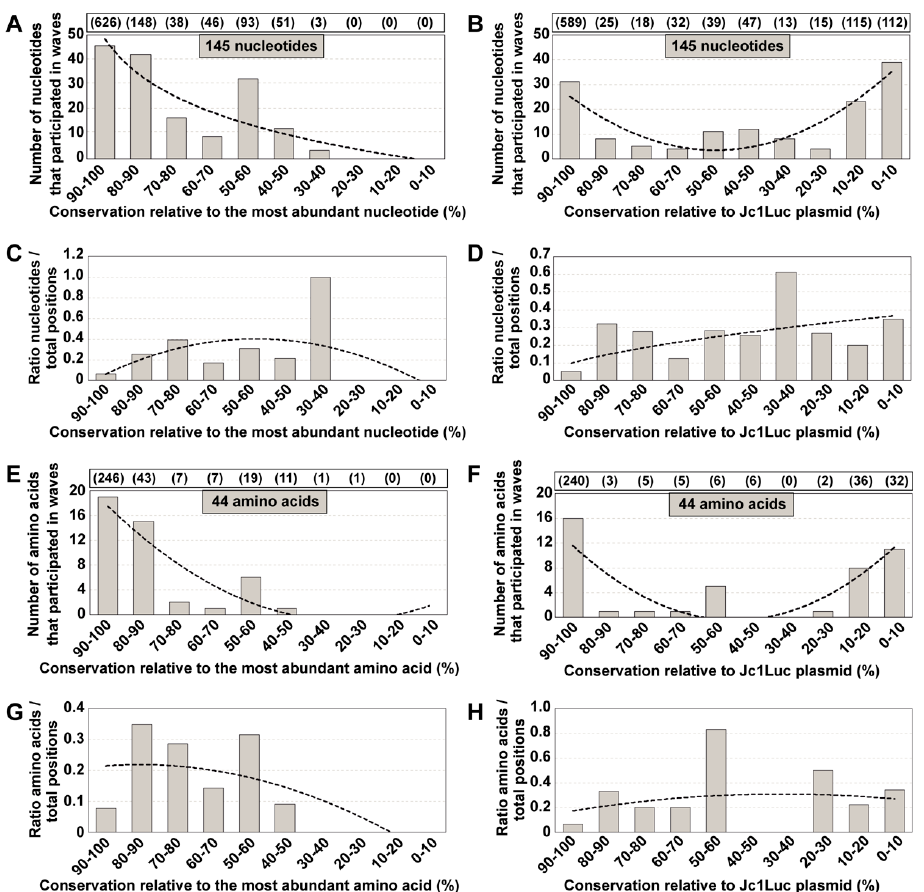
Figure 4. Degree of conservation of nucleotides and amino acids that participated in mutational waves, according to the Los Alamos National Laboratory (LANL) alignment. ( A ) Number of nucleotides involved in mutational waves distributed among conservation groups, calculated relative to the most abundant nucleotide at the corresponding position in the LANL alignment. Conservation groups are indicated in abscissa, and the number of nucleotides that participated in mutational waves in each group is given in ordinate. The total number of nucleotides within residues 7584 to 8588 (H77 numbering) from the alignment that falls in each conservation category is indicated in parenthesis in the upper box. The discontinuous line corresponds to function y = − 19.21ln(x) + 43.511 (R 2 = 0.7816). ( B ) Same as A but with nucleotide conservation in the LANL alignment calculated relative to the corresponding residues in plasmid Jc1Luc [28]. The discontinuous line corresponds to function y = 1.3068x 2 − 13.254x + 37.083 (R 2 = 0.7401). ( C ) Data of A normalized to the number of residues in each conservation group; normalization was performed by dividing the latter number by the total number of residues from the LANL alignment that fell into the corresponding group. The discontinuous line corresponds to function y = − 0.0194x 2 + 0.2013x − 0.1189 (R 2 = 0.2582). ( D ) Data of B normalized to the number of residues in each conservation group. The discontinuous line corresponds to function y = 0.0989x0.5688 (R 2 = 0.3987). ( E – H ) Same as A-D but at the amino acid level. The defining functions are E: y = 0.4205x 2 − 6.4068x + 23.45 (R 2 = 0.8178); F: y = 0.5871x 2 − 6.4826x + 17.45 (R 2 = 0.6587); G: y = − 0.0045x 2 + 0.0175x + 0.2018 (R 2 = 0.5213); H: y = 0.0644ln(x) + 0.1726 (R 2 = 0.0347). The position of each mutation and amino acid substitution is given in Table S1, and control calculations and simulations to assess the statistical relevance of the mutant distributions are described in Figure S4 and Table S6.